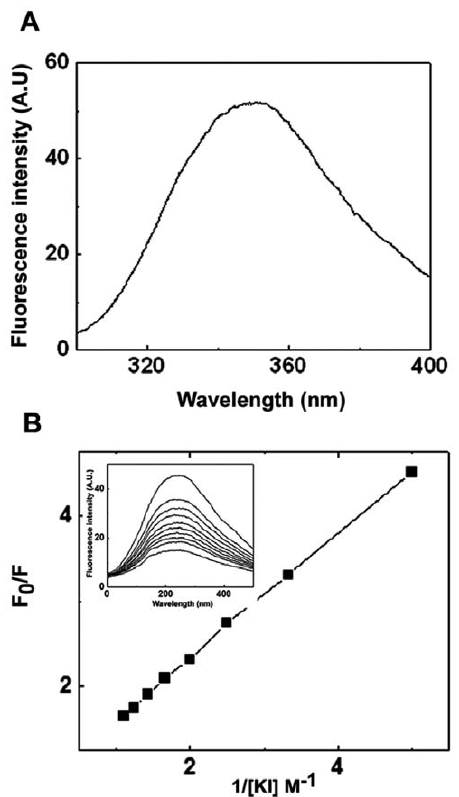
Figure 3. (a) Intrinsic fluorescence spectrum of HspB2. The excitation wavelength was 295 nm. The excitation and the emission band passes were set at 2.5 nm. The concentration of the proteins was 0.2 mg/ml. Fluorescence intensity is represented in arbitrary units. (b) Lehrer plot of tryptophan fluorescence quenching of HspB2 by KI. Fluorescence was monitored after sequential addition of KI to a solution containing 0.2 mg/ml HspB2. Insert shows the decrease in fluorescence intensity upon sequential addition of